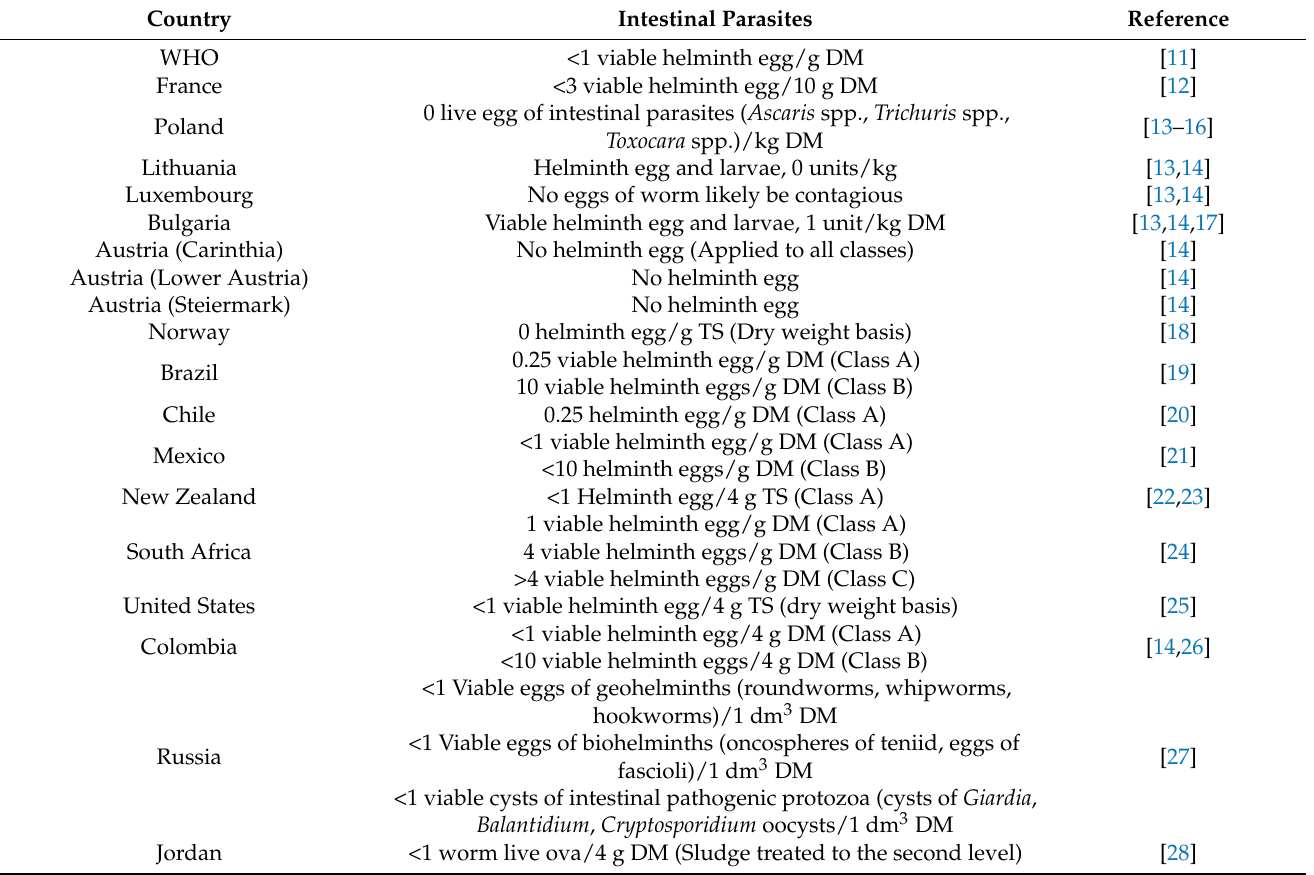
Table 1. Standards for maximum concentration of intestinal parasites for sewage sludge use in